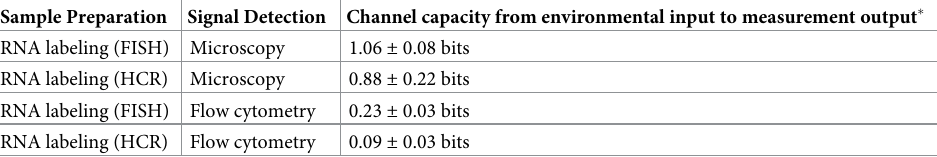
Table 1. Channel capacities of single-cell RNA measurements.